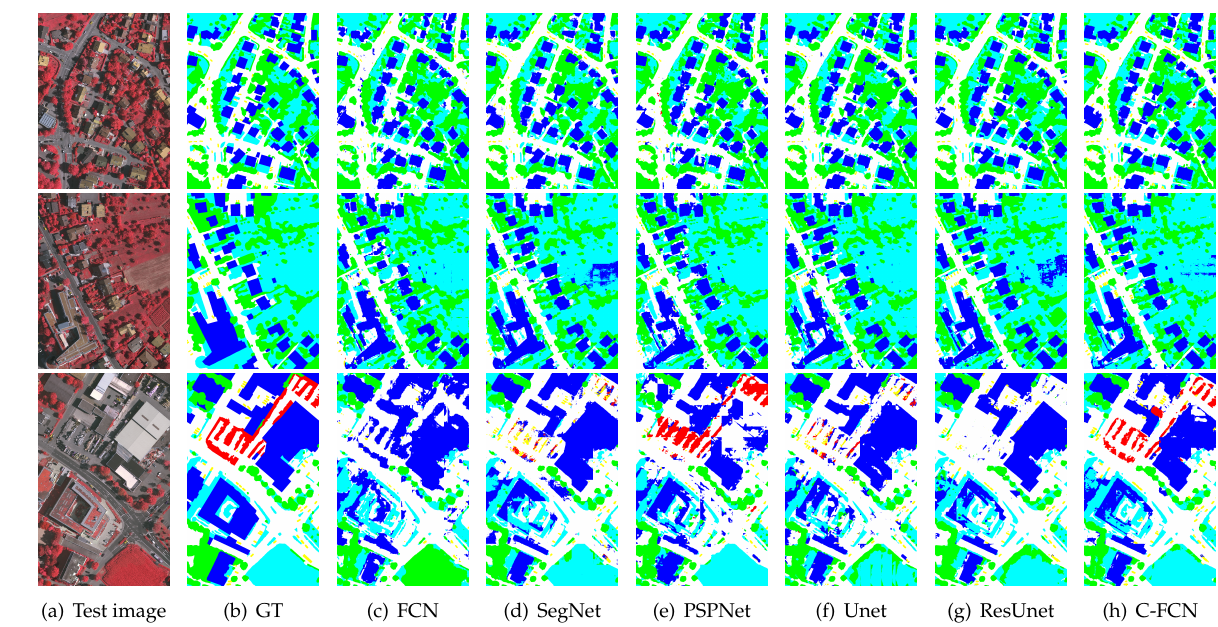
Figure 13. Visualization of some segmentation results on ISPRS Vaihingen test set. Table 4. Quantitative comparison (%) with baseline models on ISPRS Vaihingen challenge test set. Imp. Surf. Model